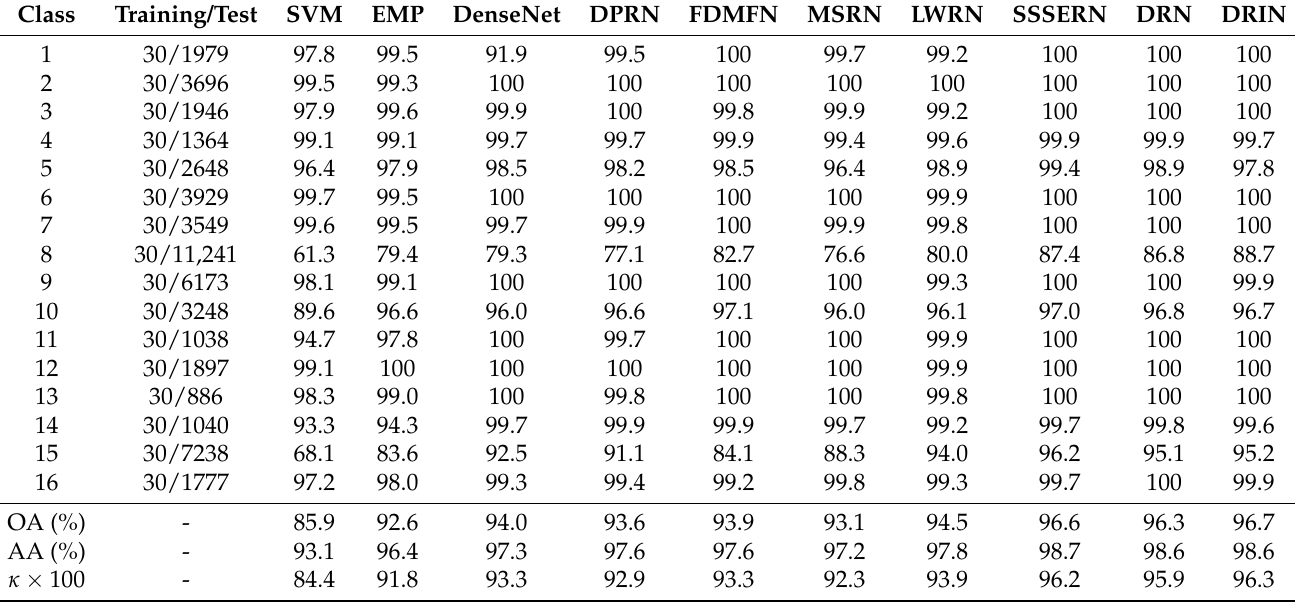
Table 11. Classification results for the SV